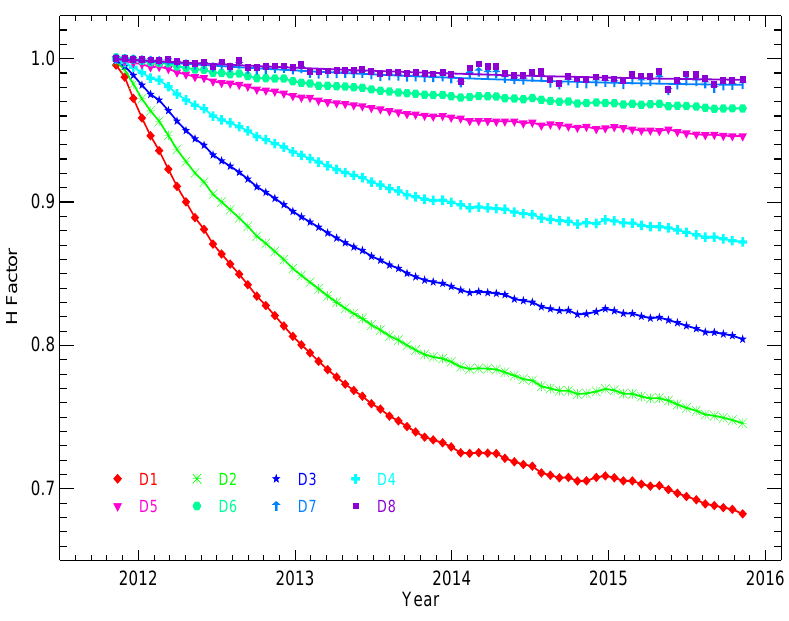
Figure 5. SD degradation derived from the SDSM measurements.